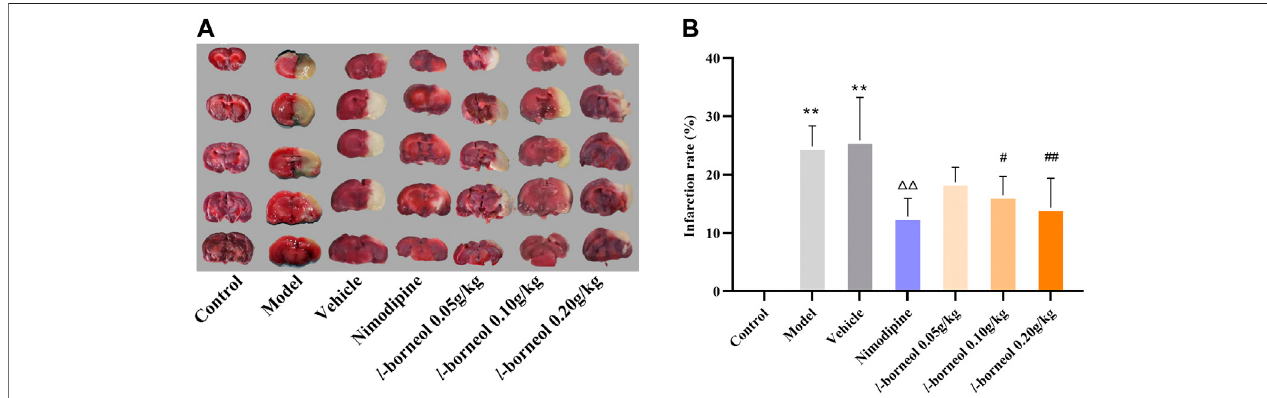
FIGURE3 | Illustrationof cerebral infarction by TTCstaining ( n (cid:2) 6). The infarcted cells showed whiteor yellow, the normal side was red. ** p < 0.01, compared with the control group; △△ p < 0.01, compared with the model group; # p < 0.05, ## p < 0.01, compared with the vehicle group.